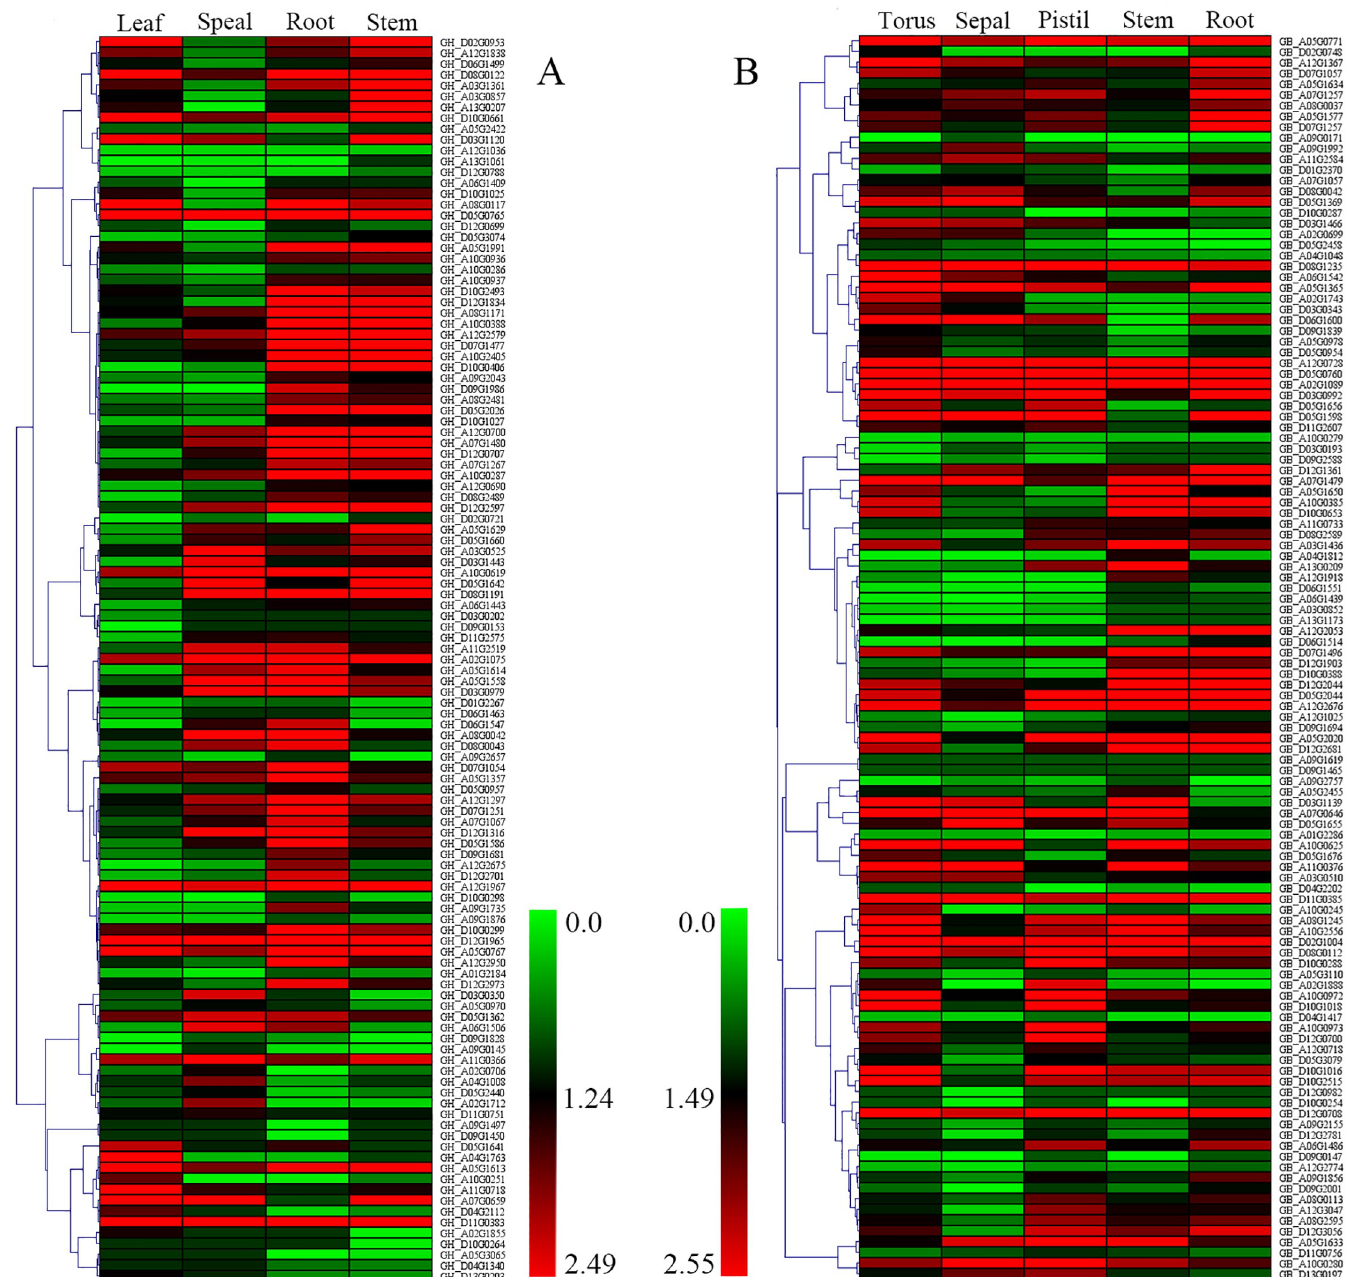
Fig 4. Expression patterns of Dof genes under different tissue. A: G . hirsutum , B: G . barbadense .